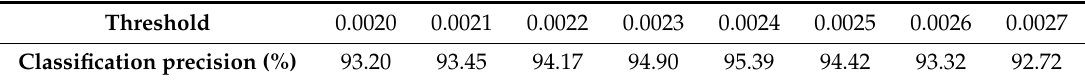
Table 2. The classification precision under different thresholds.